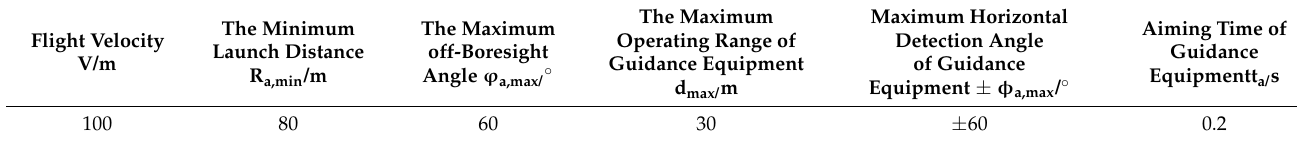
Table 3. The parameter table of UAV attack